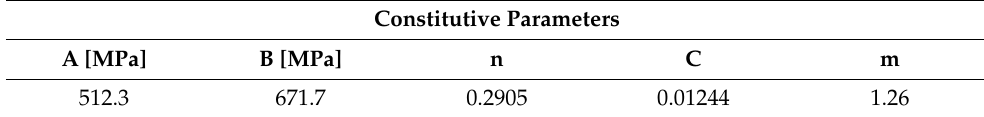
Table 2. Initial parameters of the Johnson–Cook constitutive equation.